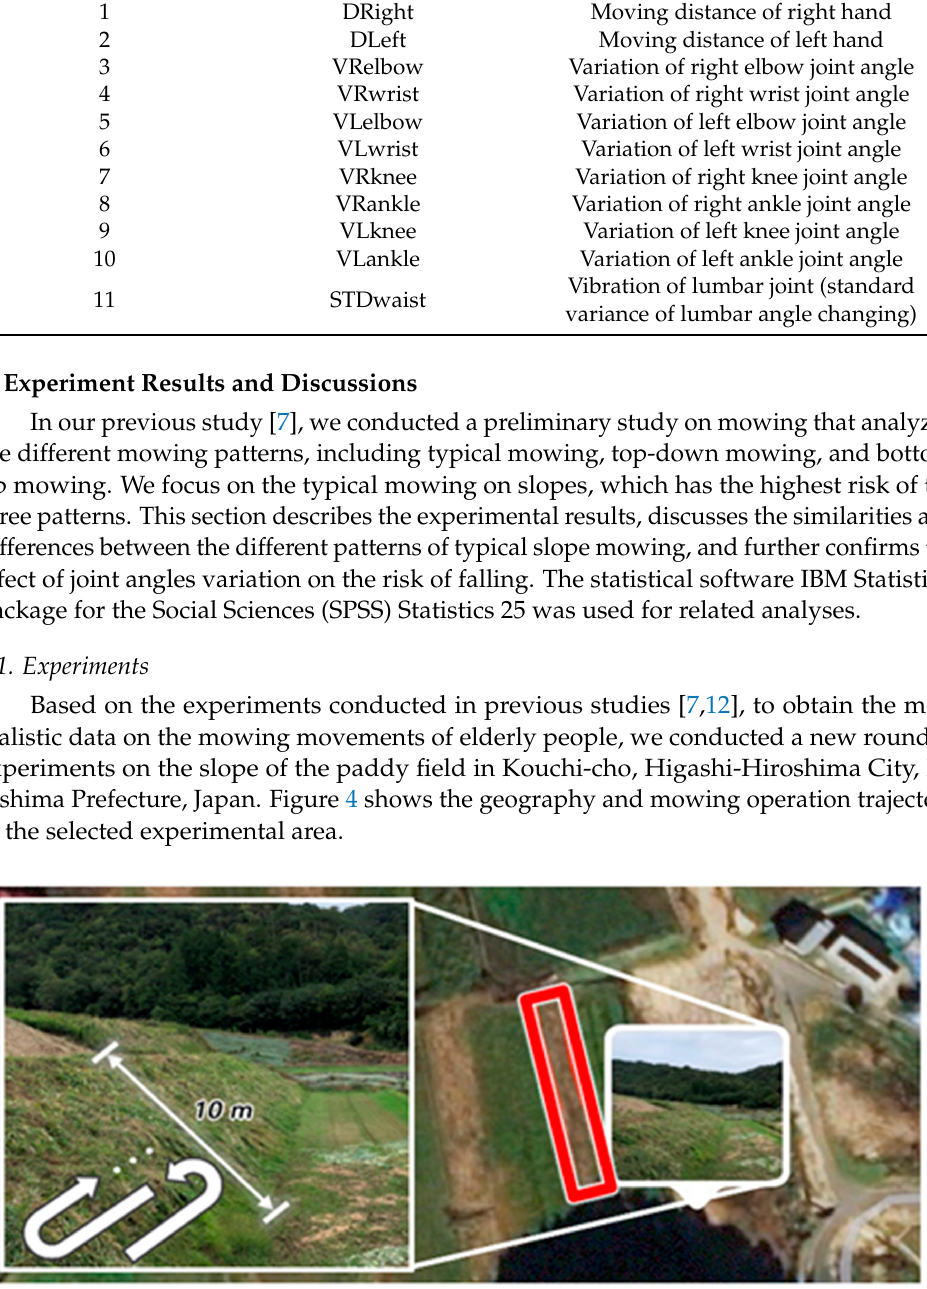
Figure 4. The geography and mowing operation trajectory of the selected experimental area. The area has a large slope angle (slope depth is over 10 m) and the weeds grow so tall that a normal mower robot cannot operate on the area. It requires the mowing worker to make several horizontal trips back and forth to cut the grass